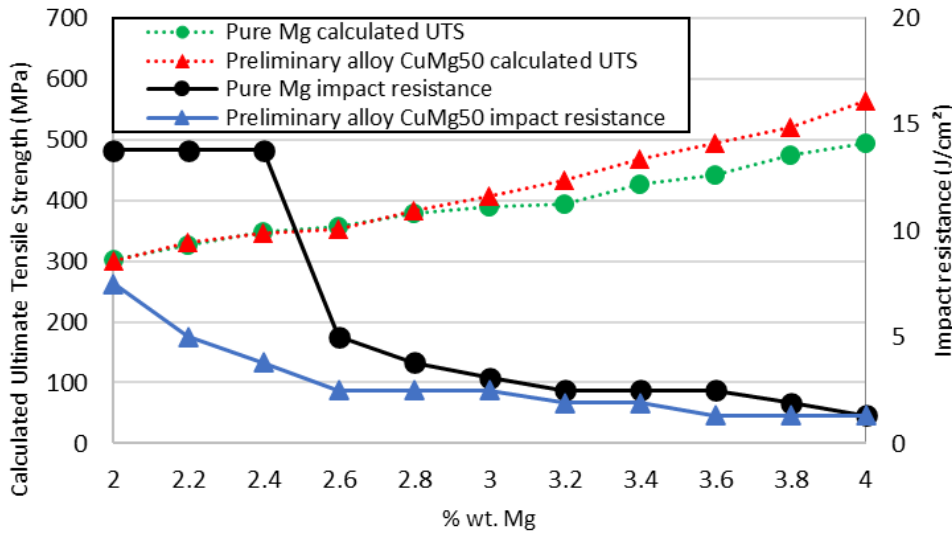
Figure 2. Average values of the calculated UTS and impact resistance of the tested materials; impact resistance marked with a full line; UTS marked with a dotted line; pure Mg marked with circles; preliminary alloy CuMg50 marked with triangles.